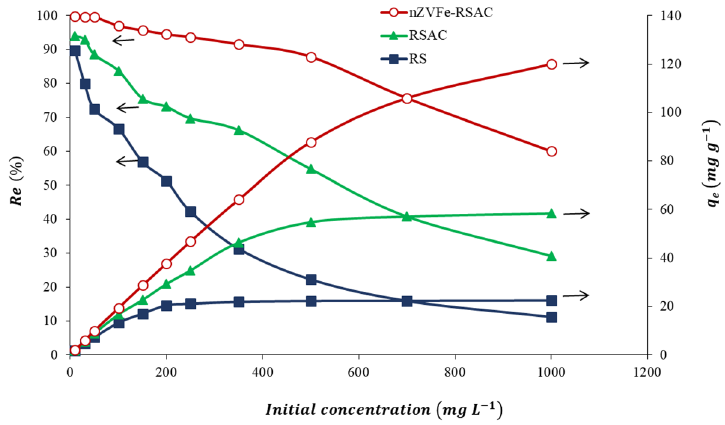
Figure 9. Effect of the initial Pb(II) concentration on the adsorption capacities of RS, RSAC, and nZVFe–RSAC (sorbent dosage = 6 (g L − 1 ), T = 25 °C).